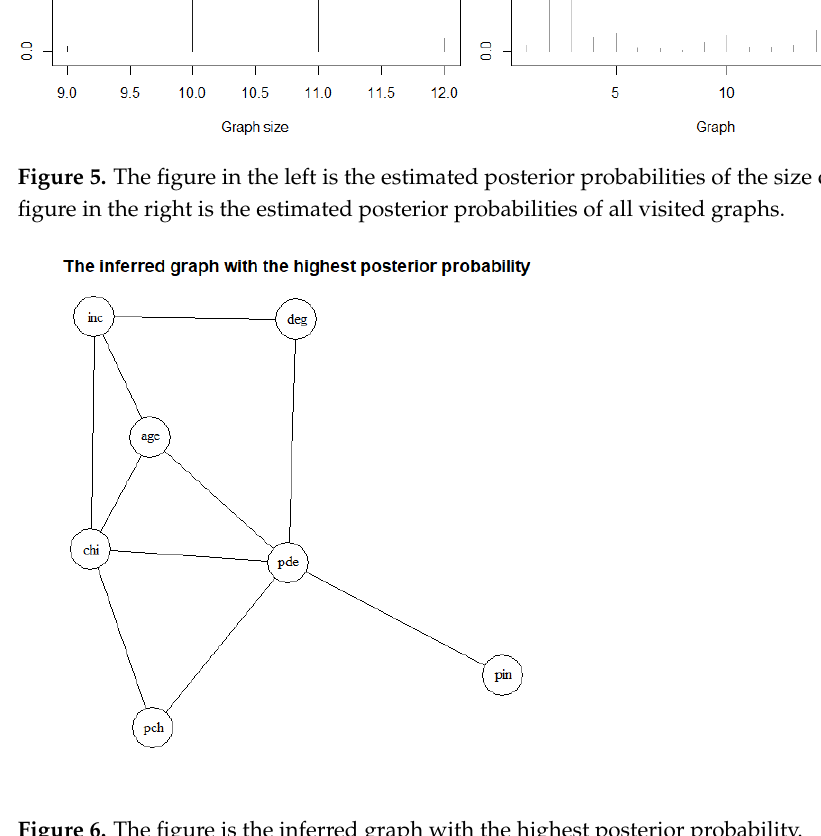
Figure 6. The figure is the inferred graph with the highest posterior